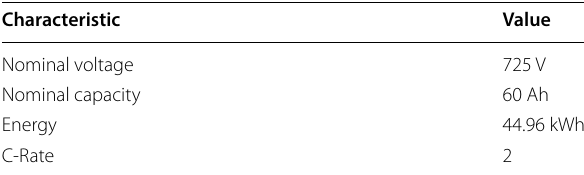
Table 28 Specifications of the LG Chem’s R800